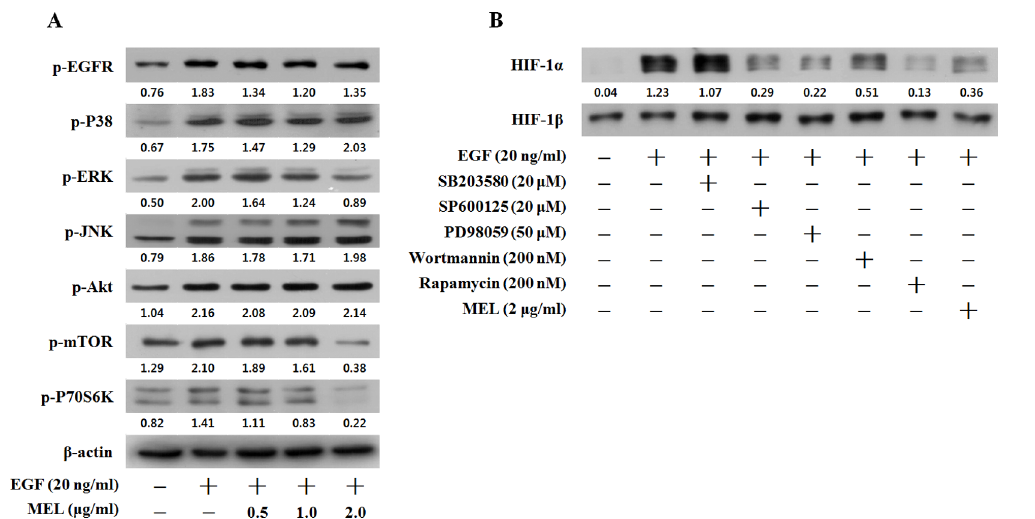
Figure 3. Melittin (MEL) suppressed the EGF-induced HIF-1 a protein synthesis by inhibiting the ERK and mTOR/p70S6K signaling pathways in the CaSki cells. (A) Effect of MEL on EGF-induced signaling leading to the expression of HIF-1 a in CaSki cells. CaSki cells were pretreated with the indicated concentrations of MEL for 1 h, followed by incubation with EGF for 30 min. The phosphorylated levels of EGFR, P38, ERK, JNK, Akt, mTOR and p70S6K were determined by Western blot analysis. (B) Effects of MEL and inhibitors on EGF-induced expression of HIF-1 a in CaSki cells. CaSki cells were pretreated with MEL, SB203580, SP600125, PD98059, wortmannin, rapamycin for 30 min, and then induced by EGF treatment for 6 h. Nuclear extracts were subjected to Western blot using antibodies against HIF-1 a or b -actin. Data represents the means 6 SD of three independent experiments. *, p , 0.05 as compared to EGF-treated control. Results were analyzed using one-way ANOVA.